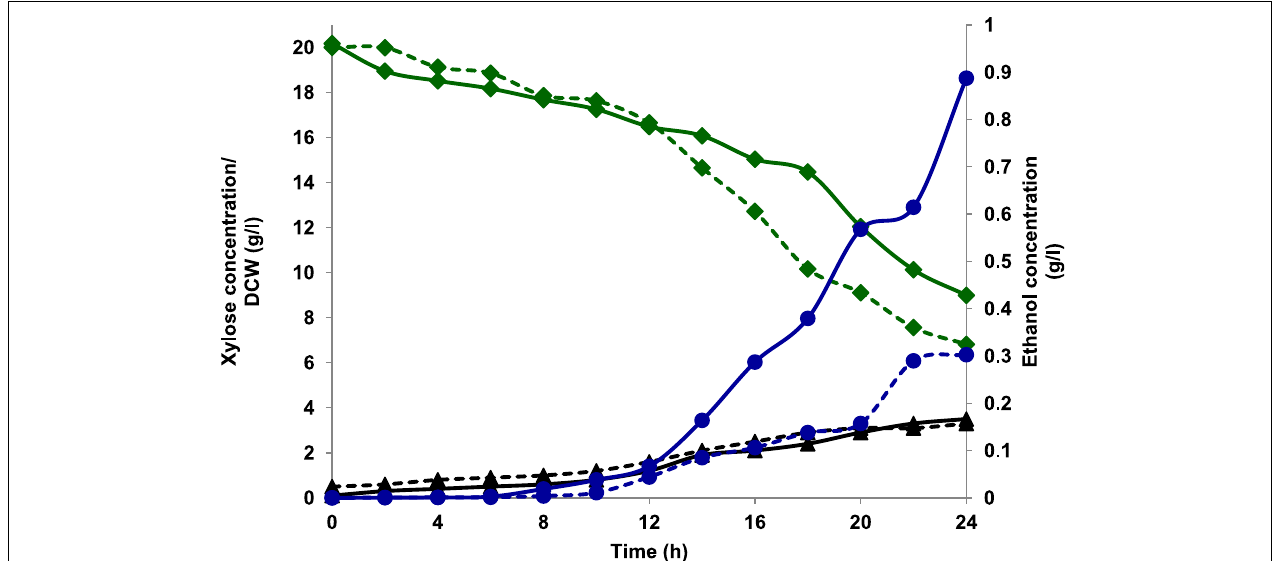
FIGURE 2 | Growth of K. marxianus NIRE-K1 and NIRE-K3 in YEPX medium, (---) K. marxianus NIRE-K1; (—) K. marxianus NIRE-K3; ( (cid:7) ) Xylose; ( N ) Dry cell weight (DCW); ( • ) Ethanol.